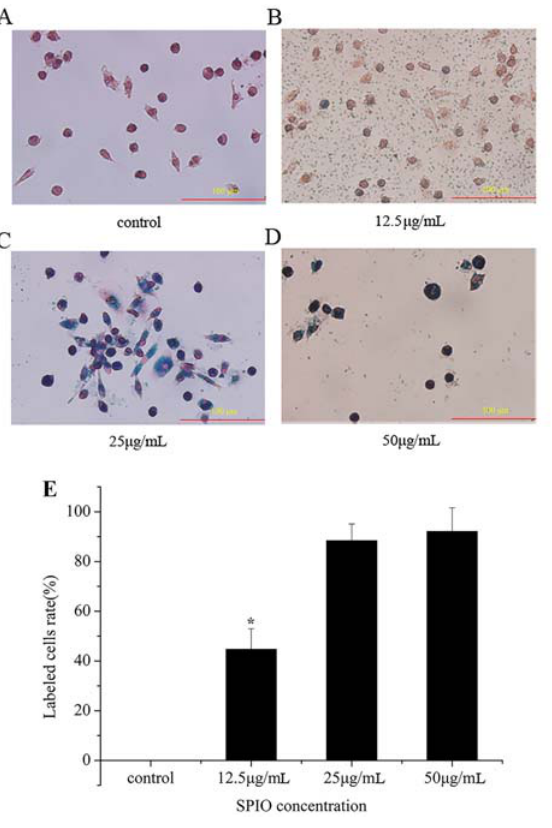
Figure 3. Endothelial progenitor cells were transfected with superparamagnetic iron oxide (SPIO) at different concentrations and observed by microscopy. A , Control group. SPIO concen- trations: B , 12.5 m g/mL; C , 25 m g/mL; and D , 50 m g/mL (scale bar 100 m m). E , Bar graph of panels A, B, C, and D. Data are reported as means ± SD. *P o 0.05 compared to control group (ANOVA). 50 m g/mL groups (Figure 4). TEM was used to observe the microcosmic conditions of EPCs transfected with SPIO at different concentrations. As shown in Figure 5,